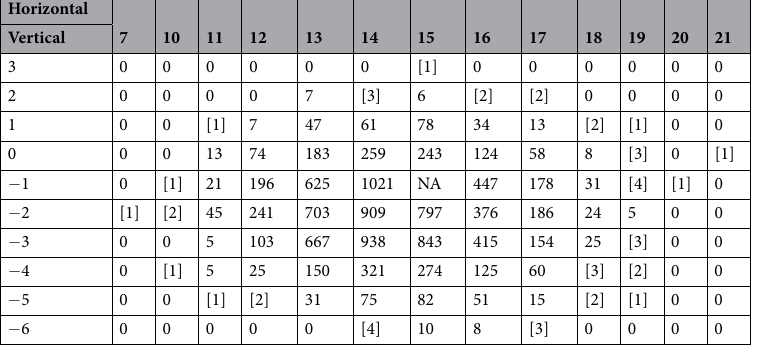
Figure 3 shows the average value of spherical equivalent (SE) over all eyes measured at each NBSL. Note that since the NBSL measurements were missing at the location (15°, − 1°), average of SE was not calculated at (15°, − 1°). We observed a negative correlation (r = − 0.14, p < 0.001) between NBSL distance from fixation and spher- ical equivalent of refractive error. As the patient became more myopic (negative refractive error), the distance between NBSL and fixation increased and vice versa. Figure 4(a) and (b) show the PD value difference distribution with respect to NBSL relative to fixation and illustrates the effect of distance from fixation and angle relative to fixation. The median NBSL distance and angle were 14.32° and 8.13°, respectively. The maximum absolute differences of average PD values between the two groups divided by median distance and angle are 0.52 dB and 0.44 dB, respectively. The distance effect of NBSL was more noticeable around the default NBSL (15°, − 1°) than other locations, while the angle effect of NBSL was relatively more spatially distributed over the VF. Figure 4(c) and (d) show the PD value difference effects com- pared by t-test with significance annotation with respect to NBSL relative to fixation and illustrates the effect of distance from fixation and angle relative to fixation. Figure 4(c) shows the average PD values of the group with NBSL distances longer than median distance decreased (red) in the upper central (average difference for signif- icant points (ADSP): − 0.18 dB) and increased (blue) in the lower nasal VF region (ADSP: 0.14 dB). Figure 4(d) shows the average PD values of the group with NBSL angles larger than median angle (more positive) decreased in lower nasal (ADSP: − 0.11 dB) and increased in upper temporal VF areas (ADSP: 0.19 dB). denoted by blue/red color, respectively, together with the significance of the respective coefficient for each loca- tion for (a) NBSL distance, (c) NBSL angle, and the respective coefficients for fixation loss ((b) and (d)). The PD values of all significant locations were negatively associated with fixation rate loss as shown in Fig. 5(b) and (d). Those significant locations that were negatively associated with PD values spread over most regions of the VF.